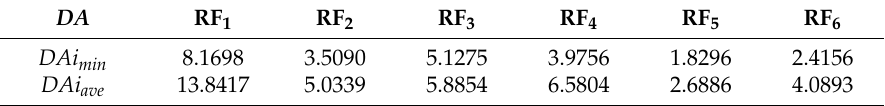
Figure 13. The spatial distribution map of the six REB faults based on ( f 2 , f 6 , f 19 , f 32 , f 95 ).